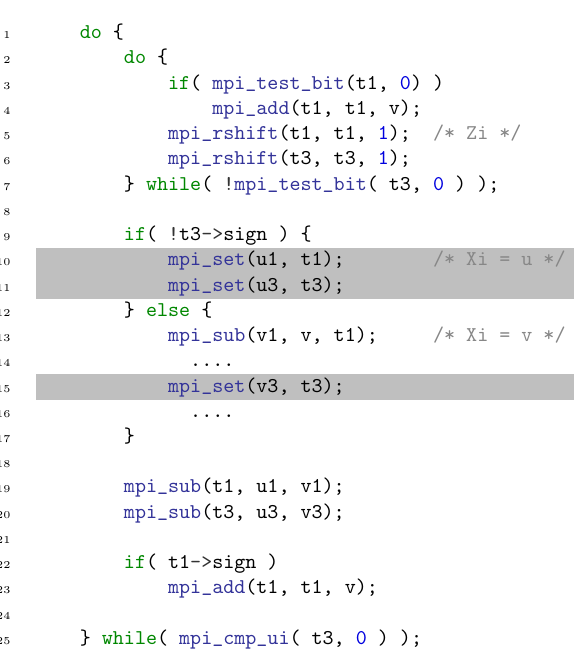
Figure 1: BEEA variant as implemented in libgcrypt